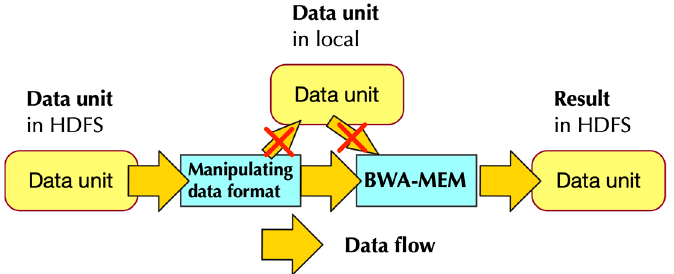
Figure 6. Data flow of the main computation stage. It shows that data are not stored in local-disk through the whole main computation.